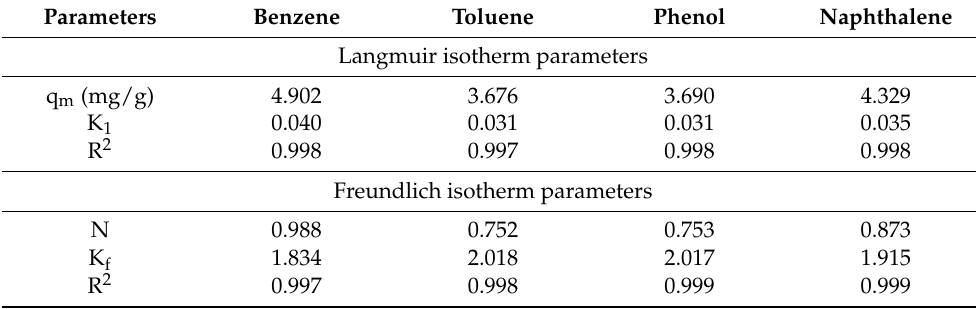
Table 4. Isotherm parameters for adsorption of model HCs on AC.